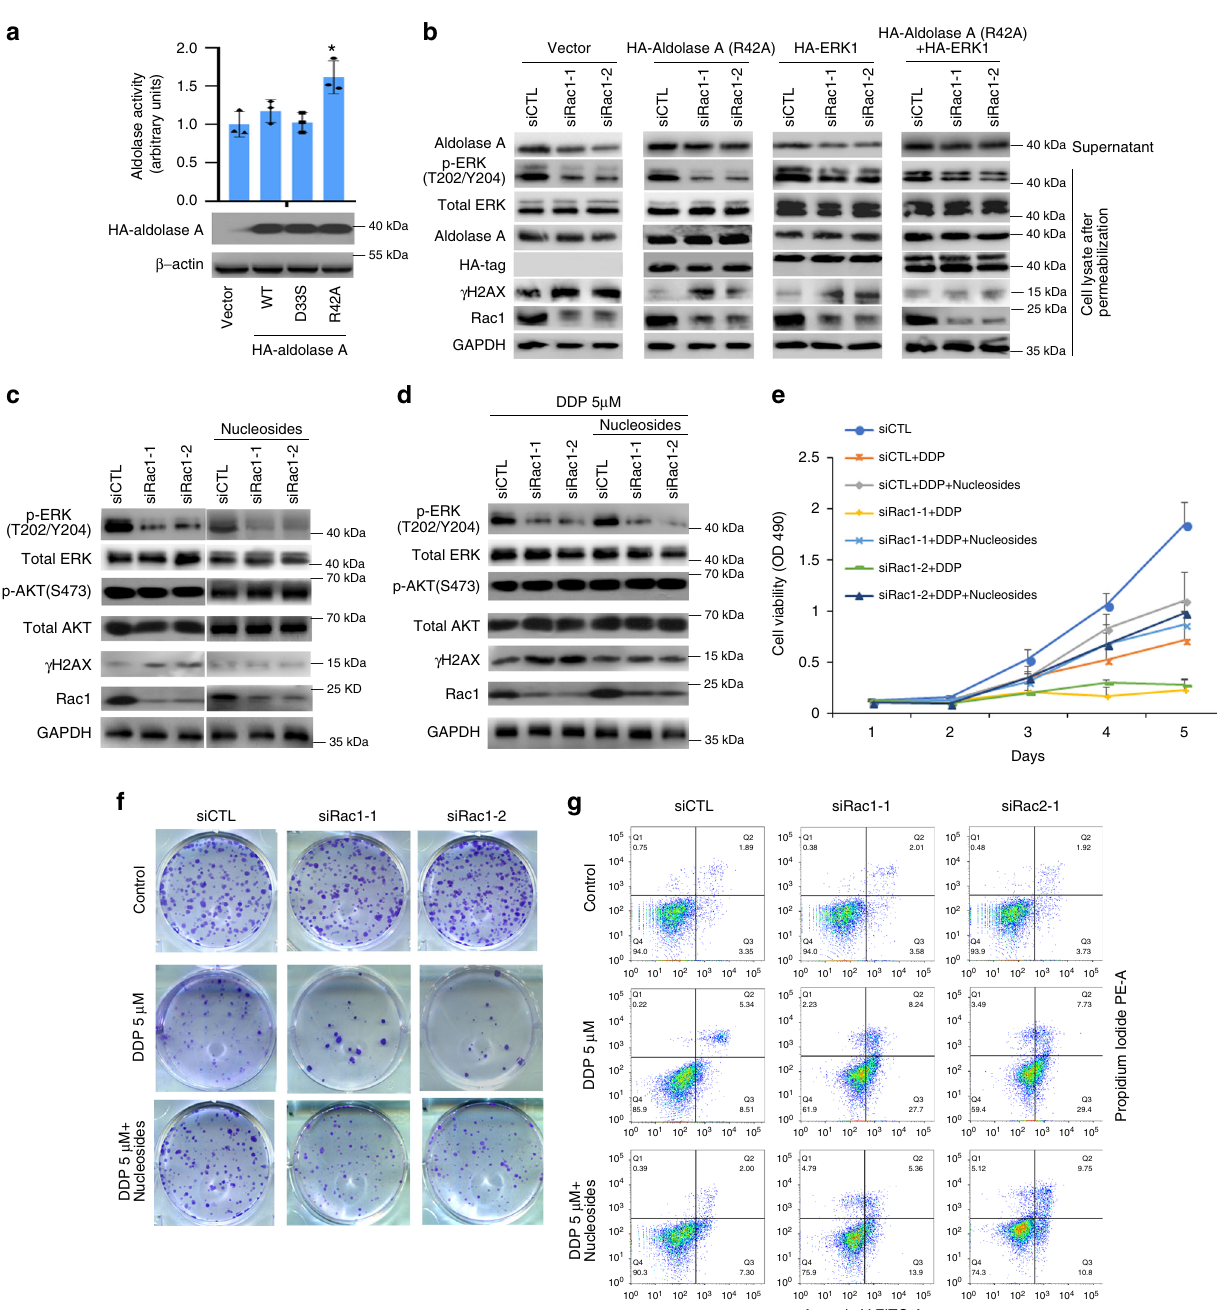
Fig. 5 Rac1 knockdown induced DNA damage can be rescued by exogenous expression of aldolase, ERK1 and nucleosides repletion. a Exogenous expression of aldolase A mutant (R42A) signi fi cantly increased aldolase enzyme activity. Exogenous expression of wild-type and mutant aldolase A in MDA-MB-231 cells were detected by western blots (lower panel). The aldolase activity was determined by the enzyme assay (upper panel). The result was obtained over three independent experiments. Bar graphs represent the mean ± SD of experimental triplicates. * p < 0.05. b Effects of exogenous expressed HA-aldolase A (R42A) or HA-ERK1 on abrogating γ H2ax upregulation induced by Rac1 knockdown. MDA-MB-231 cells were transfected with empty vector, HA-aldolase A (R42A) or HA-ERK1 after transiently transfected with siCTL, siRac1-1, and siRac1-2 for 48 h, washed with cold PBS and then permeabilized with 30 μ g/ml digitonin/PBS for 5 min at 4 °C . Then the supernatant was collected and the cells were lysed for immunoblotting. The result was obtained over three independent experiments. c , d Effects of nucleosides repletion on abrogating γ H2ax upregulation induced by Rac1 knockdown with ( c ) or without DDP treatment ( d ). MDA-MB-231 cells were transiently transfected with siRNAs for 48 h and then treated with or without 5 μ M DDP for 24 h in the cultured medium with additional indicated nucleosides ( a , g , c , u ; 100 μ M). The result was obtained over three independent experiments. e – g Nucleosides rescued siRac1-induced phenotypes upon DDP treatment. MTS assay ( e ), colony formation assay ( f ), and apoptosis assay ( g ) were performed to evaluate the effects of nucleosides repletion ( a , g , c , u ; 100 μ M) on rescuing Rac1 silencing phenotypes upon DDP treatment. Bar graphs represent the mean ± SD of experimental triplicates ( e , f ). Bar graphs represent the mean ± SD of three independent experiments ( g ). Also see Supplementary Fig. 4E, F. Source data are provided as a Source Data fi